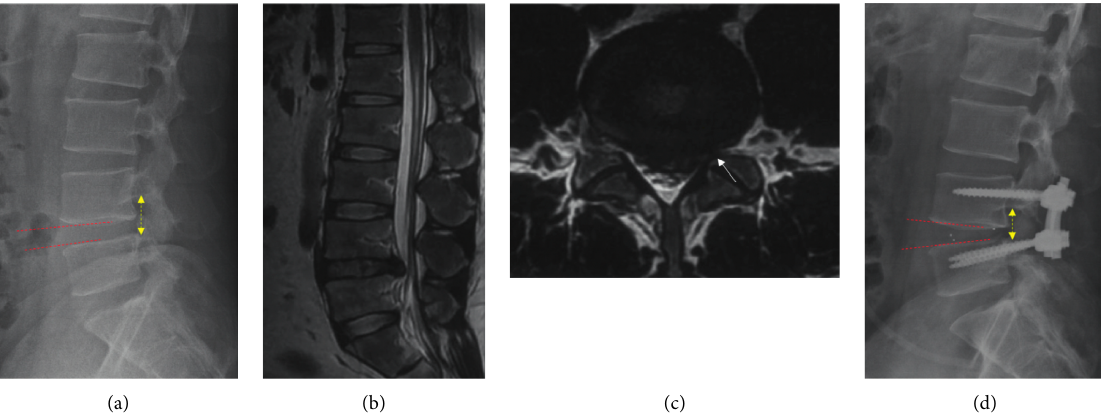
Figure 5: Images of the case: (a) preoperative lateral X-rays; (b) preoperative sagittal MRI; (c) preoperative axial MRI; and (d) postoperative lateral X-rays.